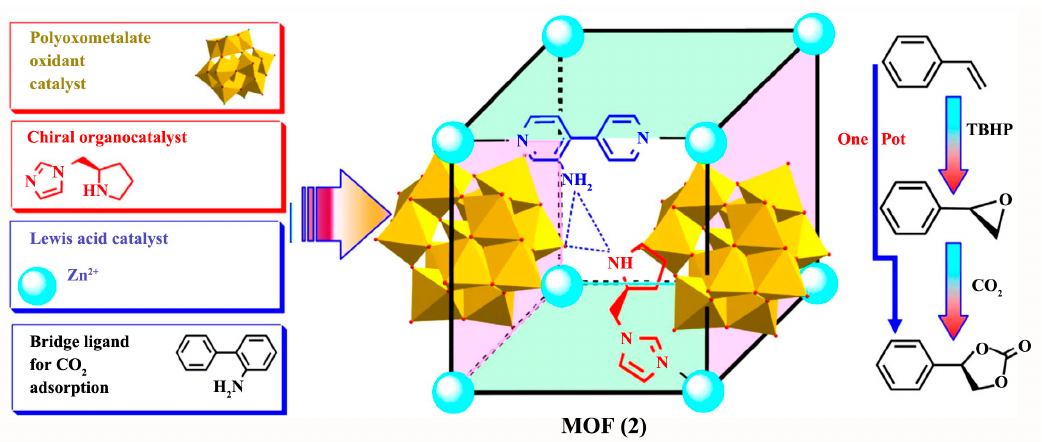
Figure 3. Synthetic procedure of the homochiral MOF ZnW-PYI ( 2 ) and schematic representation of the catalytic synthesis of cyclic-carbonates. Reproduced from [54] with permission from Nature Publishing Group. Publishing Group.